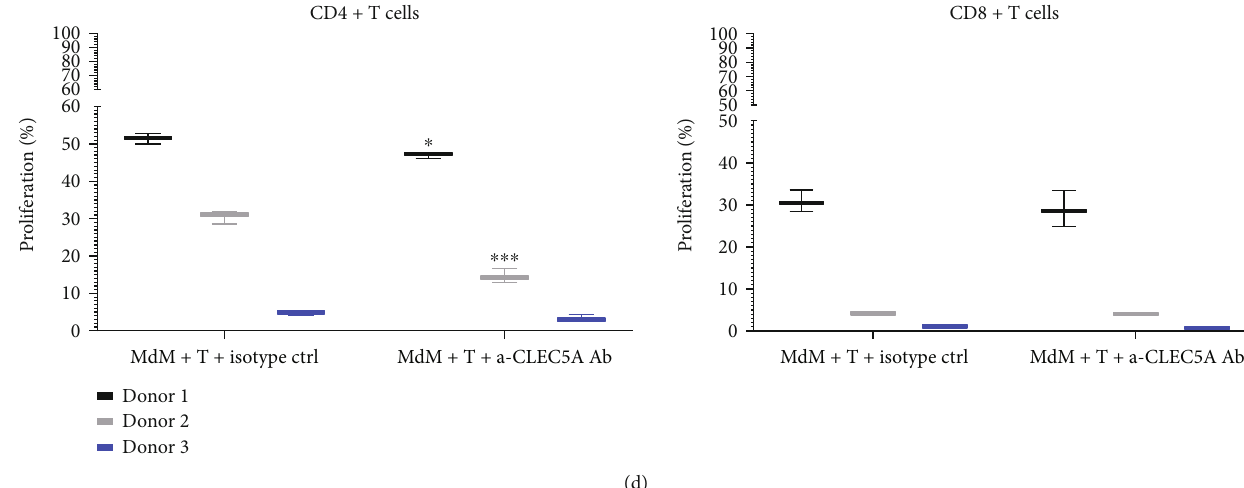
Figure 8: CLEC5A receptor activation on MdM does not support autologous T cell priming. MdM generated from monocytes in the presence of M-CSF (a) or GM-CSF (b) were cocultured for 48h with pan T cells that were puri fi ed from same donors and preactivated with 0.1 μ g/mL a-CD3 Ab. T cell-derived IL-2 secretion was measured by ELISA in cell culture supernatants. Proliferation of CD4+ (left) and CD8+ T cells (right) cocultured for 5 days with M-CSF (c) or GM-CSF (d) macrophages in the presence of 0.1 μ g/mL α -CD3 Ab was measured by fl ow cytometry. The cells were stained in 100 μ L FACS bu ff er containing 1 :20 diluted FACS antibodies against CD4 and CD8 antigens. Values represent the mean and SD from three technical replicates per donor. Shown is the summary result of two independent experiments with six donors (a and b) and one experiment with three donors (c and d); ∗ p < 0 : 033 , ∗∗ p < 0 : 002 , and ∗∗∗ p < 0 : 001